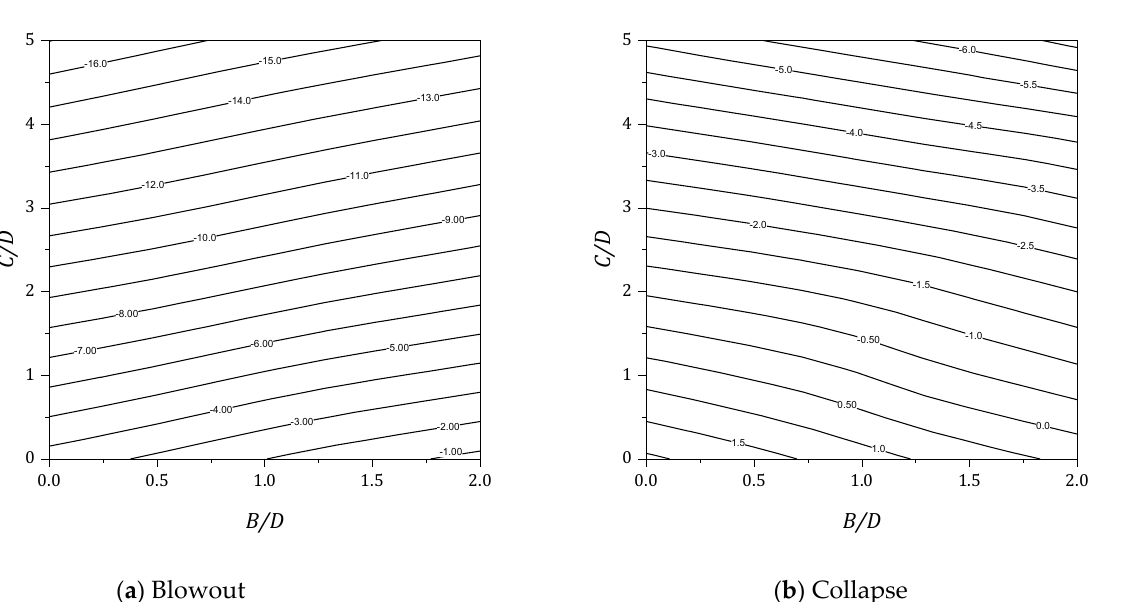
Figure 14. Design charts for γ D/S u = 1.